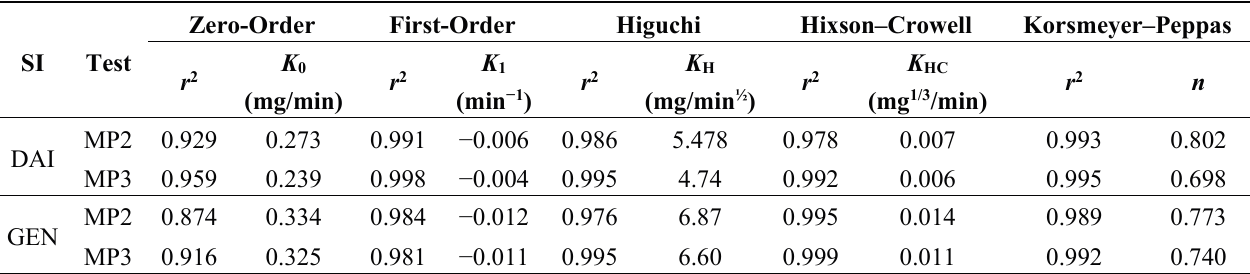
Table 2. Release parameters of DAI and GEN from isoflavone-loaded microparticle formulations. SI: soy isoflavon DAI: daidzein; GEN: genistein; r 2 : regression